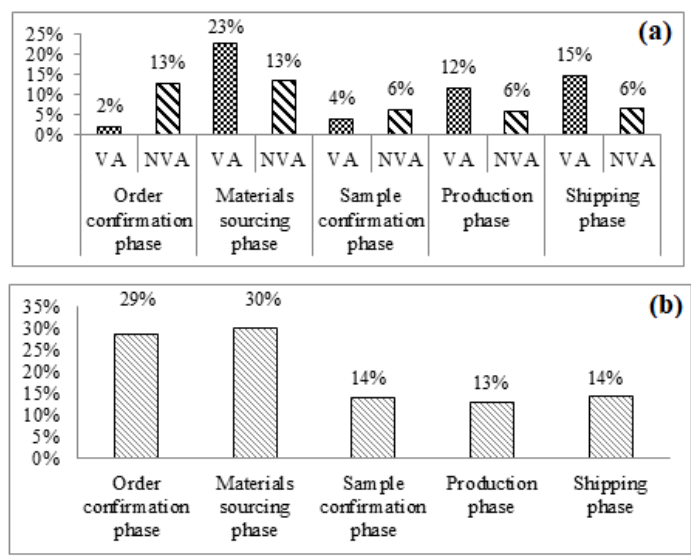
Figure 6. (a) Phase wise value/non-value added activities, (b) % of non-value against total